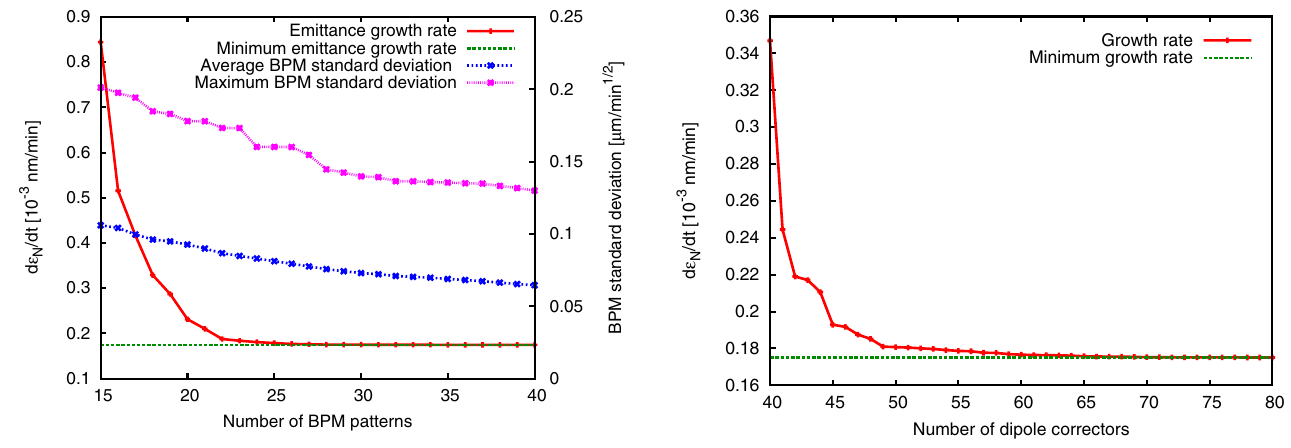
FIG. 8. (Color) Emittance growth rate for an optimized feedback system constructed using a variable number of dipole correctors. Using as few as 60 correctors, a performance within 1% of what is optimal can be obtained. For 70 correctors, the growth rate is approximately 0.14% higher than the optimal. Note that the corrector that is most useful for solving Eq. (63) is not neces- sarily the most efficient for feedback. This is, e.g., seen between corrector 42 and 45 where the correctors are selected in the wrong order. As a consequence, it could be possible to use even a few correctors less if a more advanced selection algorithm is used.